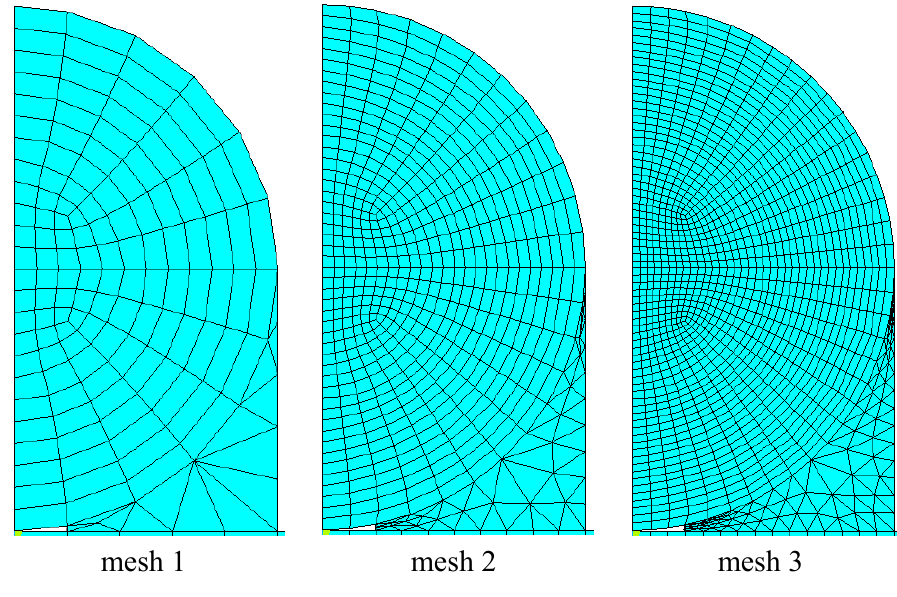
Figure 2. Three different finite element